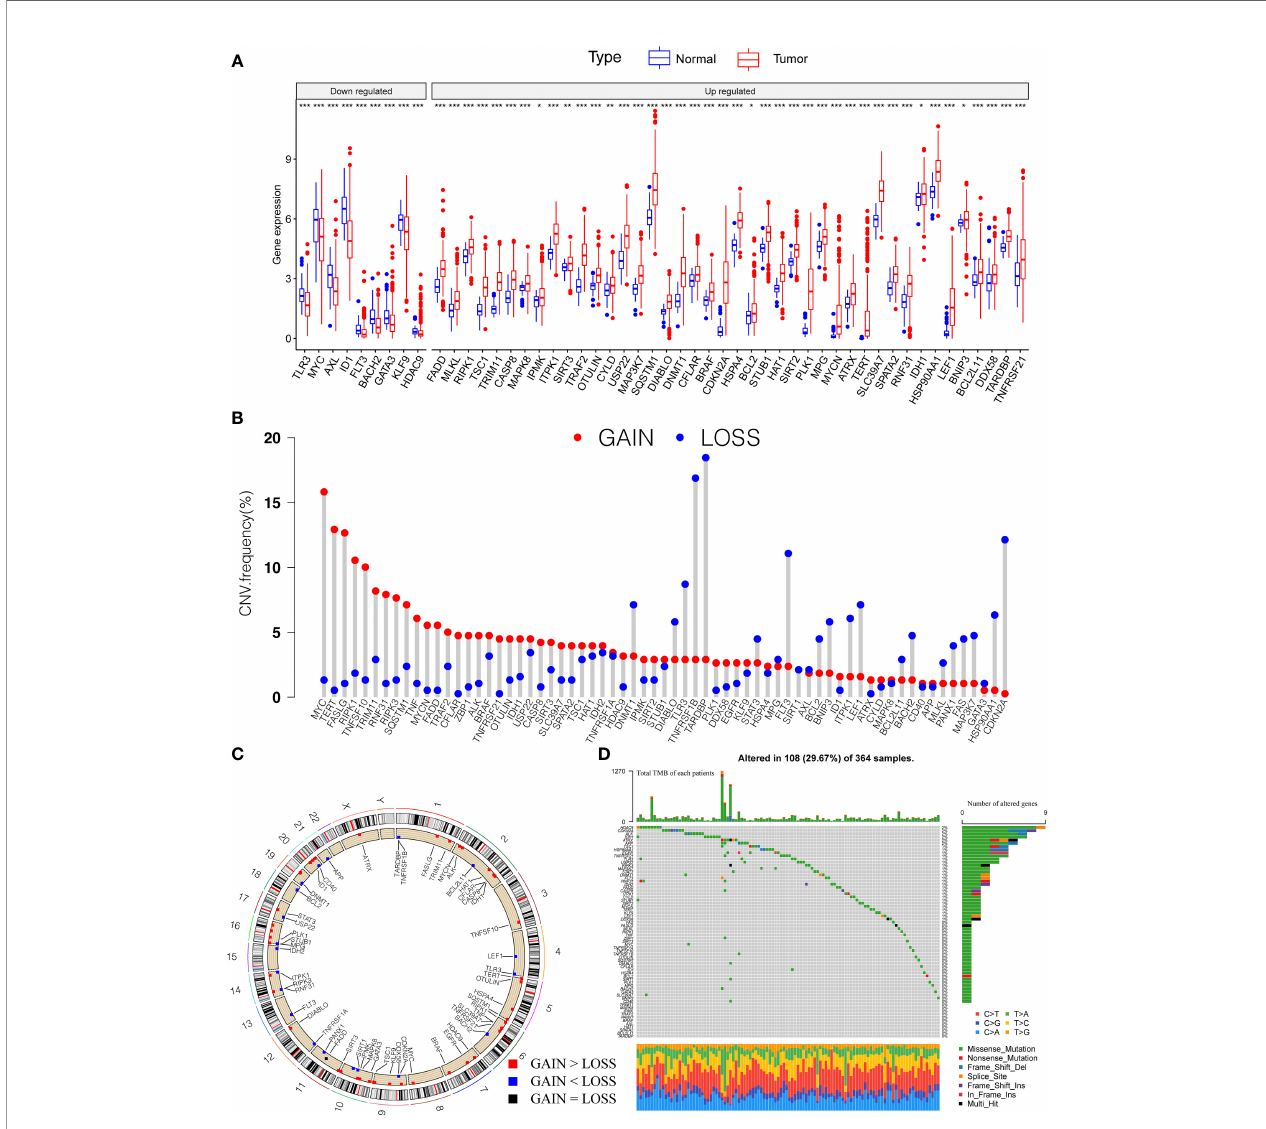
FIGURE 1 | Genetic landscape and expression variation of necroptosis regulators in HCC. (A) The differential expression level of necroptosis regulators between tumor and normal tissues. (B) CNV alternation of necroptosis regulators in tumor tissues. Column represented the frequency of the variations. The green dot represented the deletion of CNV. The red dot represented the ampli fi cation of CNV. (C) Location of CNV of necroptosis regulators in chromosomes. Red dots represent genes gain than loss, blue dot presents genes loss than gain and the black dot means loss equal gain. (D) One hundred eight patients (29.67%) exhibited various genetic alterations, including missense, nonsense, splice, frameshift, and multiple mutations. Each column indicated individual HCC patients, and the upper bar diagram exhibited the TMB of HCC patients. The right number represented the mutation frequency, and the bar diagram on the right exhibited the proportion of each genetic alteration. P<0.05 *; P<0.01**; P<0.001***. HCC, hepatocellular carcinoma; CNV, copy number variation; TMB, tumor mutation